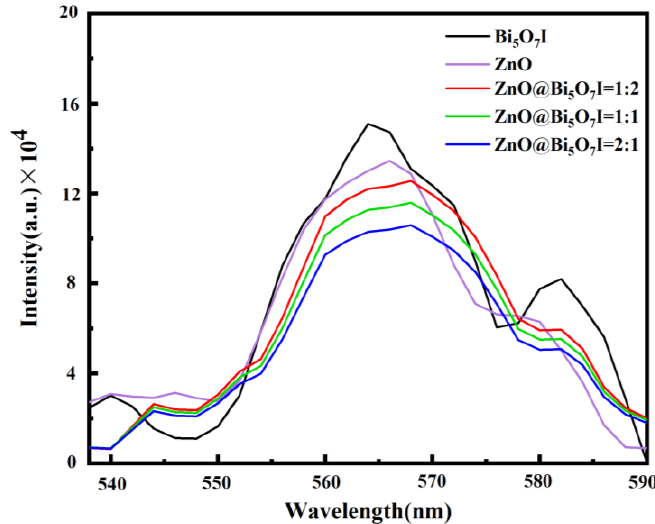
Figure 5. ZnO, Bi 5 O 7 I and emission fluorescence spectra of binary composites.